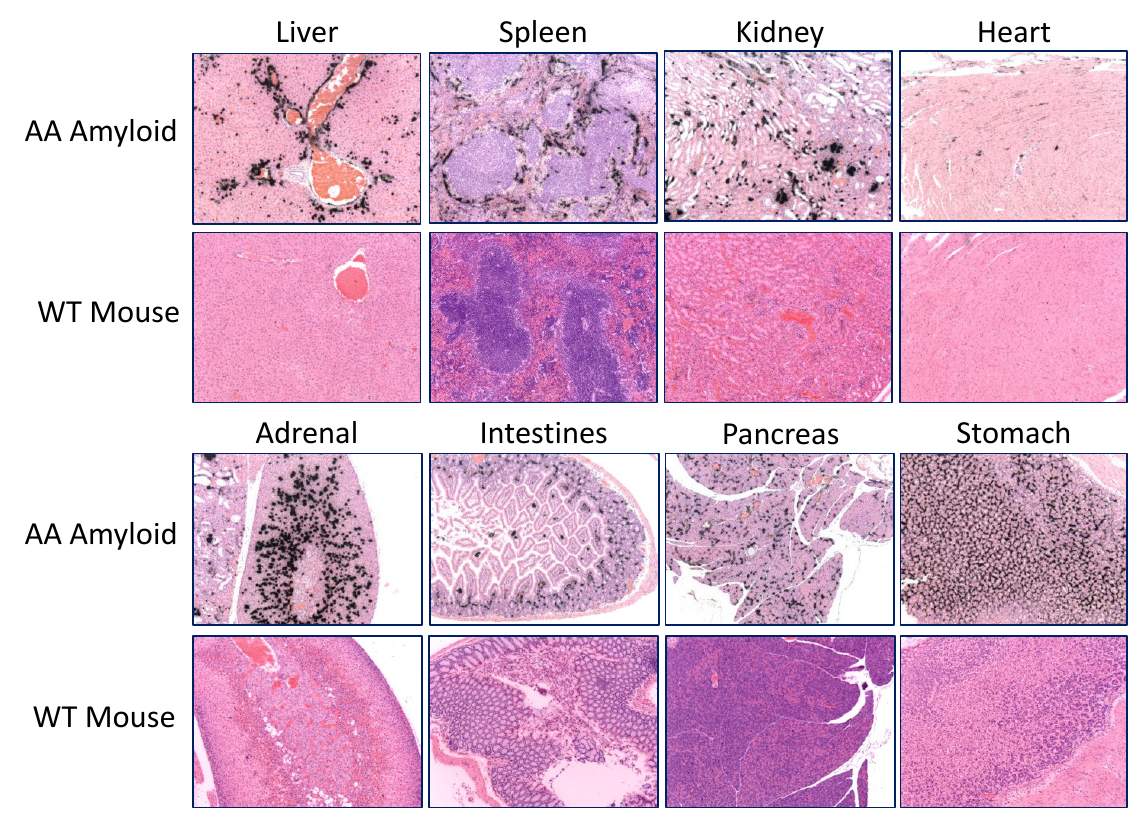
Figure 4. Microautoradiographic analysis of organs from AA and WT mice at 1 h pi revealed specific localization of 125 I-p5+14 with tissue amyloid deposits. The binding of grains at the sites of amyloid deposition. No binding of the radiolabeled peptide was seen in amyloid-free WT mice. Original magnification, 10×